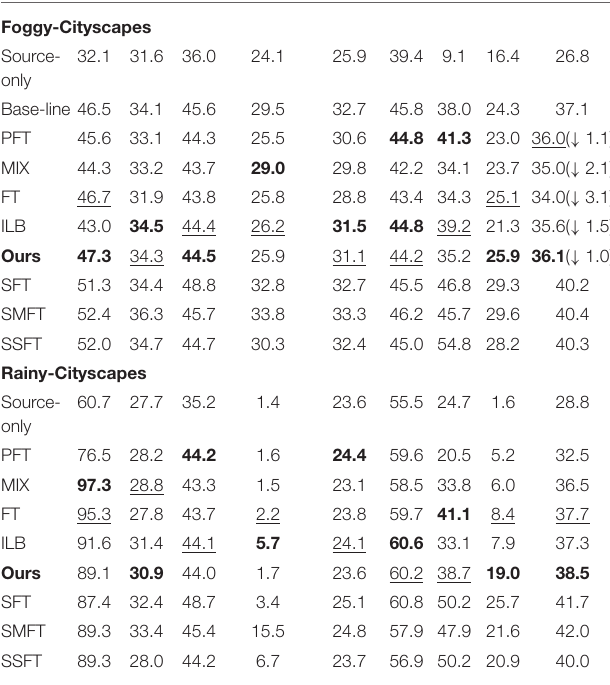
TABLE 1 | Results of “Diverse Weathers” adaptation.